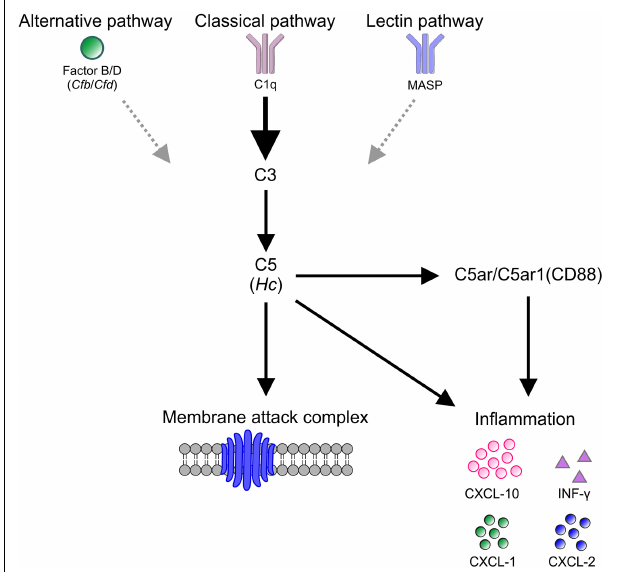
FIGURE 7 | Schematic overview of study findings. In β B1-CTGF mice, which develop glaucomatous damage, an activation of the complement, predominantly via the classical pathway (C1q), could be detected. The activation of C5 ( Hc ) eventually lead to the assembling of the membrane attack complex (MAC), which harms retinal ganglion cells directly. Further, C5 as well as C5a receptors, namely the C5a anaphylatoxin receptor ( C5ar ) and the complement component C5a receptor 1 ( C5ar1 , CD88), engage a pro-inflammatory response of INF- γ , CXCL-10, CXCL-1, and